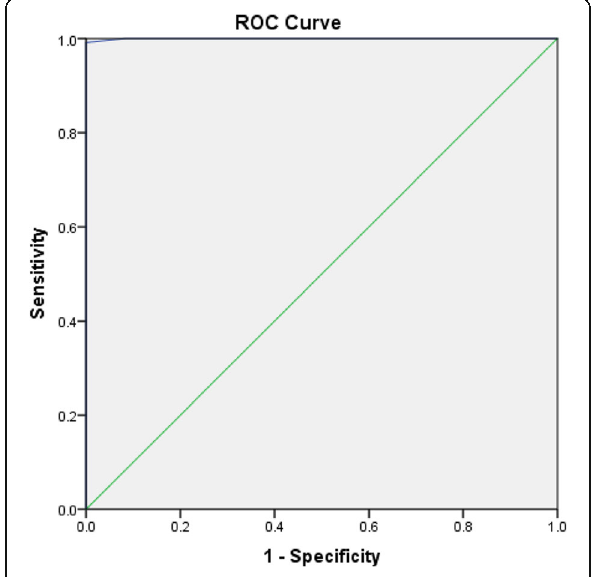
Fig. 5 ROC curve presenting the BCR between the patients and controls